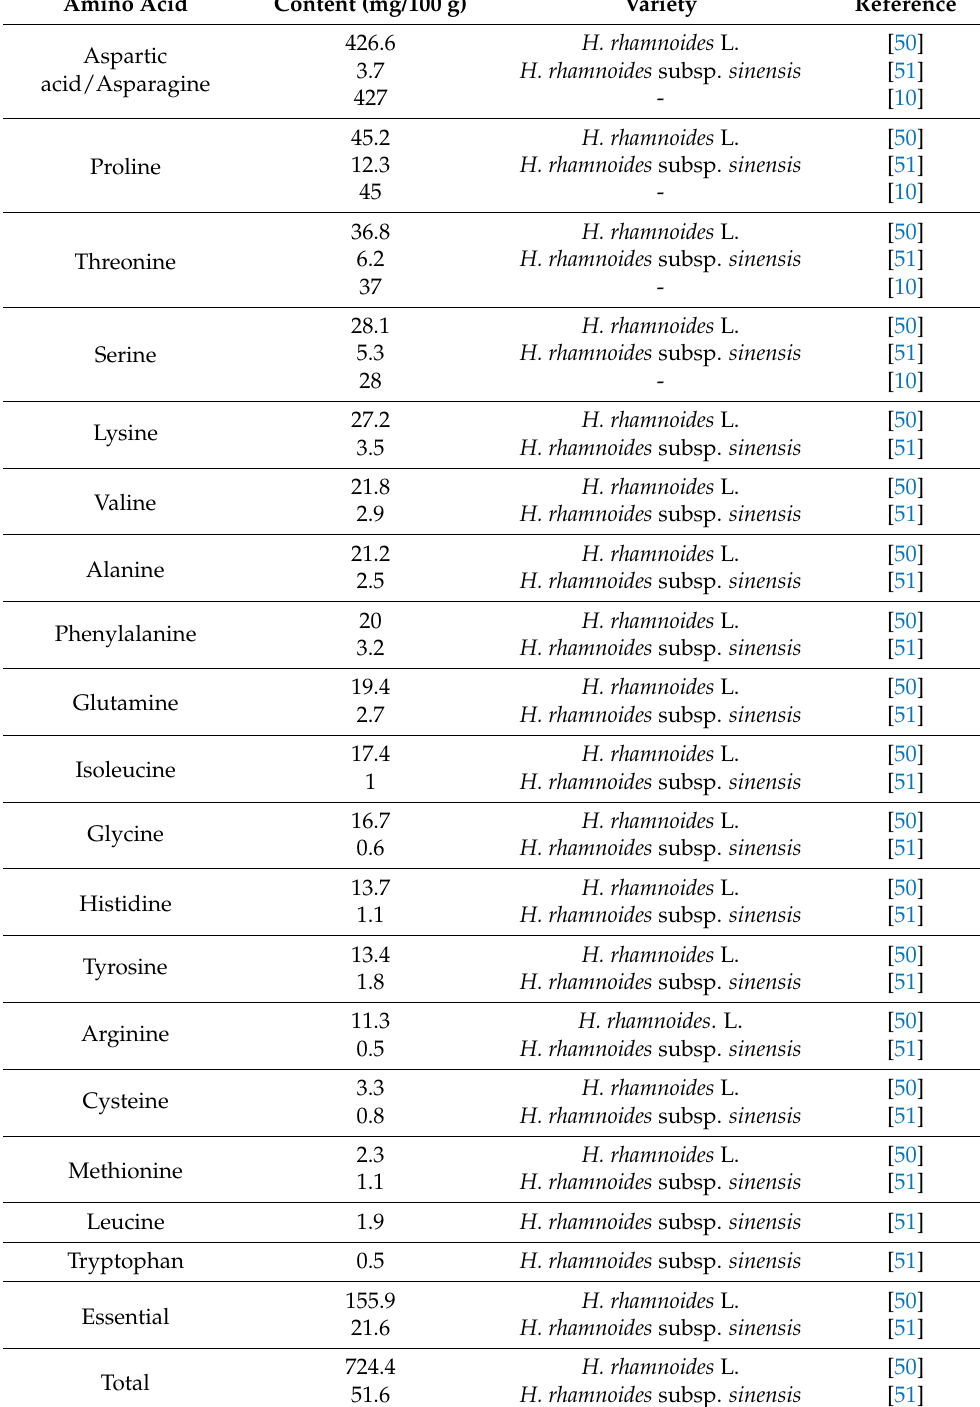
Table 3. Content of various amino acids in sea buckthorn juice. Amino